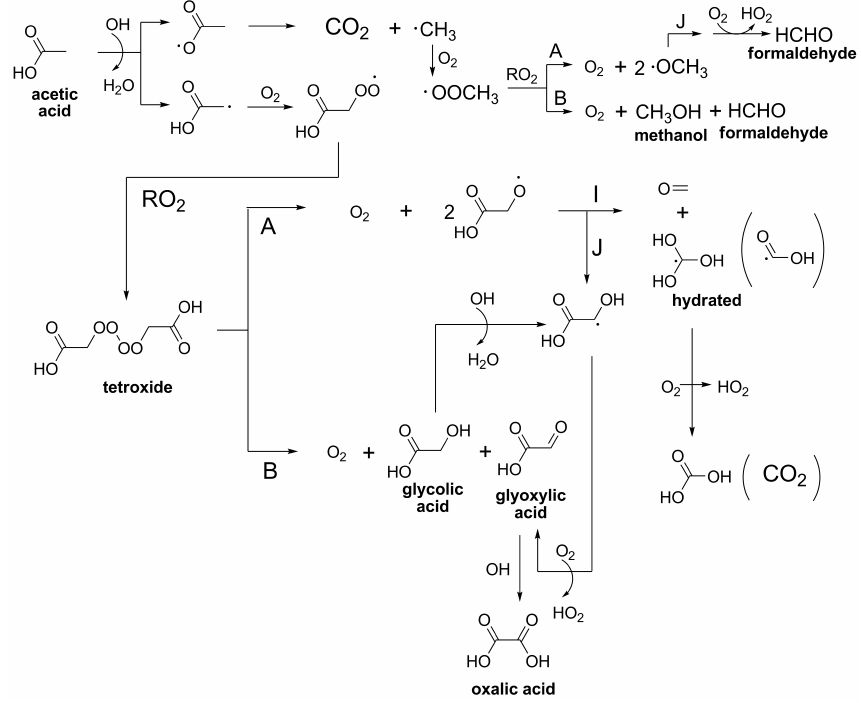
Fig. 2. Reaction mechanisms for the reactions of acetic acid with OH radicals in the aqueous phase. RO 2 represents bimolecular RO 2 –RO 2